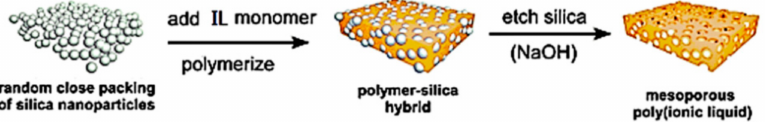
Figure 8. Schematic overview of the employed hard-templating method for synthesis of mesoporous poly(ionic liquid) [83]. Reprinted with permission of American Chemical Society.